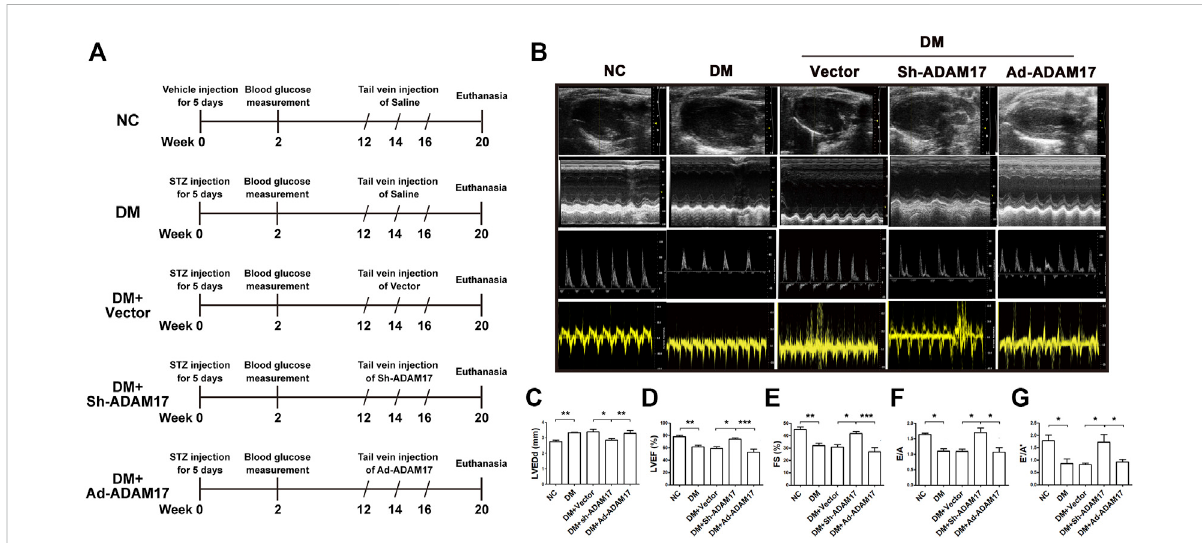
FIGURE 1 Timelineofexperimentalstudiesandechocardiographicmeasurementsin5groupsofmice. (A) Animalgrouping andtimelineofexperimental studies in 5 groups of mice. (B) Representative two-dimensional echocardiograms ( fi rst row), M-mode echocardiograms (second row), pulse-wave Doppler spectra of mitral in fl ow (third row), and tissue Doppler spectra of mitral annulus (fourth row). (C) Measurements of left ventricular end- diastolic diameter (LVEDd) in 5 groups of mice. (D) Measurements of left ventricular ejection fraction (LVEF) in 5 groups of mice. (E) Measurements of fractional shortening (FS) in 5 groups of mice. (F) Measurements of ratio of early to late left ventricular fi lling velocity (E/A) in 5 groups of mice. (G) Measurements of ratio of early to late diastolic peak annular velocity (E ’ /A ′ ) in 5 groups of mice. Data were expressed as the means ± SEM. * p < 0.05, ** p < 0.01, *** p < 0.001. n = 10 per